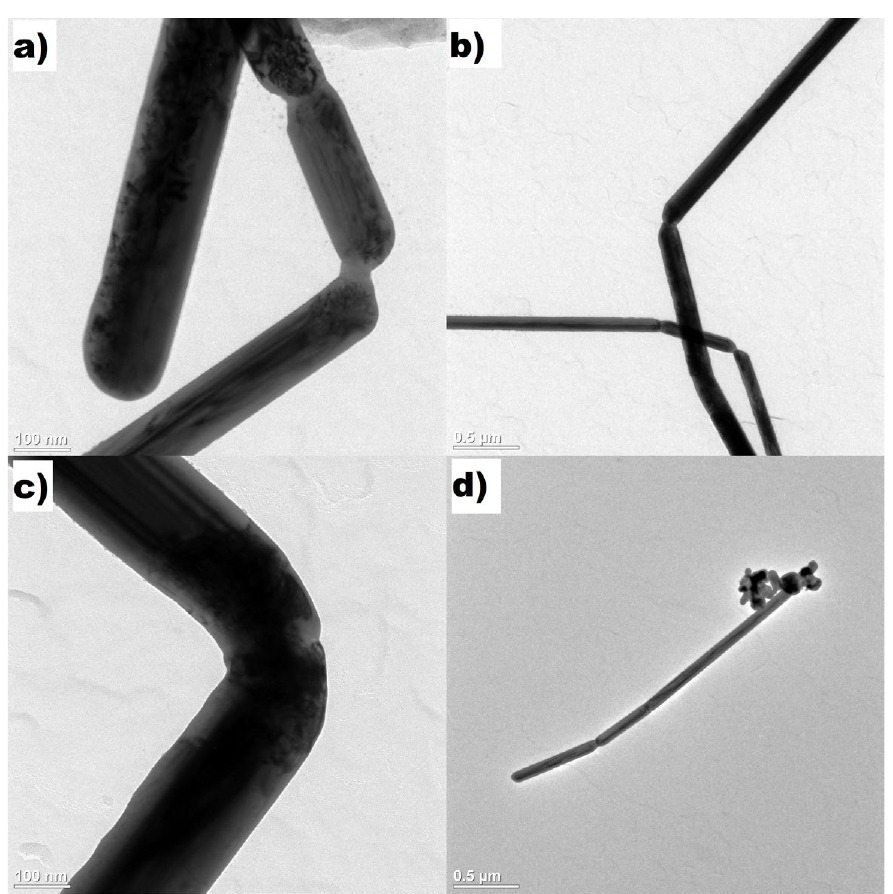
Figure 8. Growth of the AgNWs due to mutual attachments of one-dimensional objects: ( a , b , d ) different variants of nanowire-nanowire and nanowire-nanorod structures, ( c ) V-shape junction.